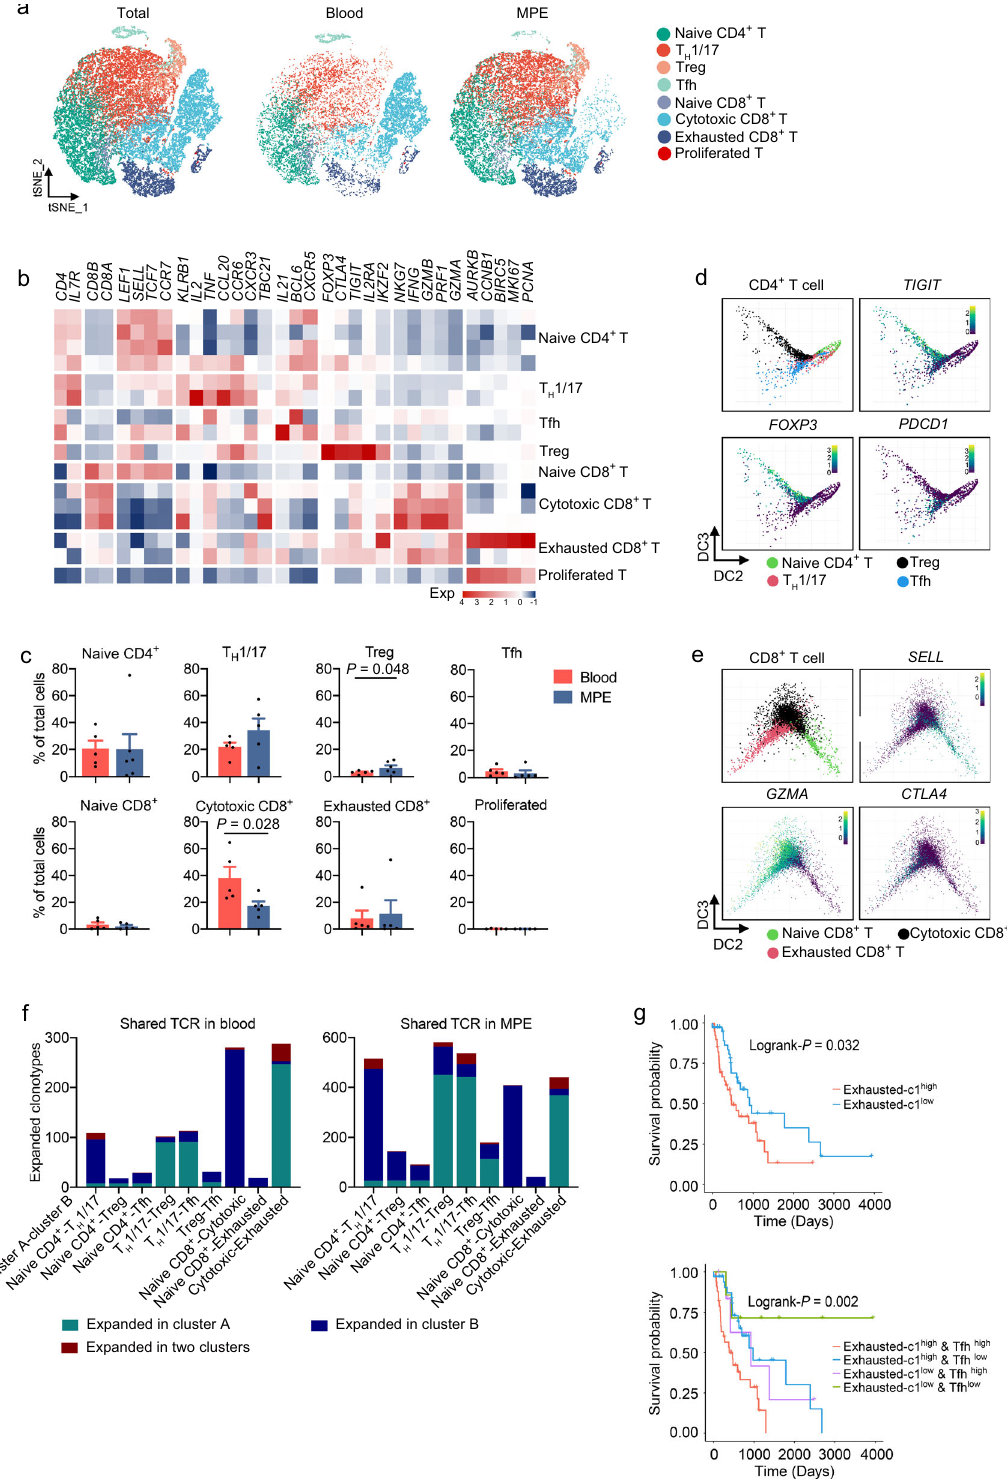
Fig. 2 Dissection and clustering of T cells in MPE patients. a t-SNE plots of T cells within each cell type, color-coded by T cell subsets. b Heatmap of selected T cell marker genes in each T cell subset. c Frequencies of T cell subsets in MPE and blood according to the t-SNE plot using scRNA-seq data. Data are presented as mean ± SD. Comparisons were made using two-tailed paired Student ’ s t test. Blood, n = 5 samples; MPE, n = 5 samples. d Diffusion map of CD8 + T cell functional state transitions. DC diffusion component. e Diffusion map of CD4 + T cell functional state transitions. DC diffusion component. f Bar plots summarizing the distributions of expanded TCRs between given two clusters. TCR T cell receptor. g The Kaplan – Meier overall survival curves of TCGA LUAD patients grouped by the gene signature of exhausted-c1 (upper panel) or exhausted-c1 and Tfh (lower panel). The high and low groups are divided by the median value of the mean expression of signature gene after normalization by T cell fractions estimated by CIBERSORT. The statistical signi fi cance was calculated using two-sided log-rank